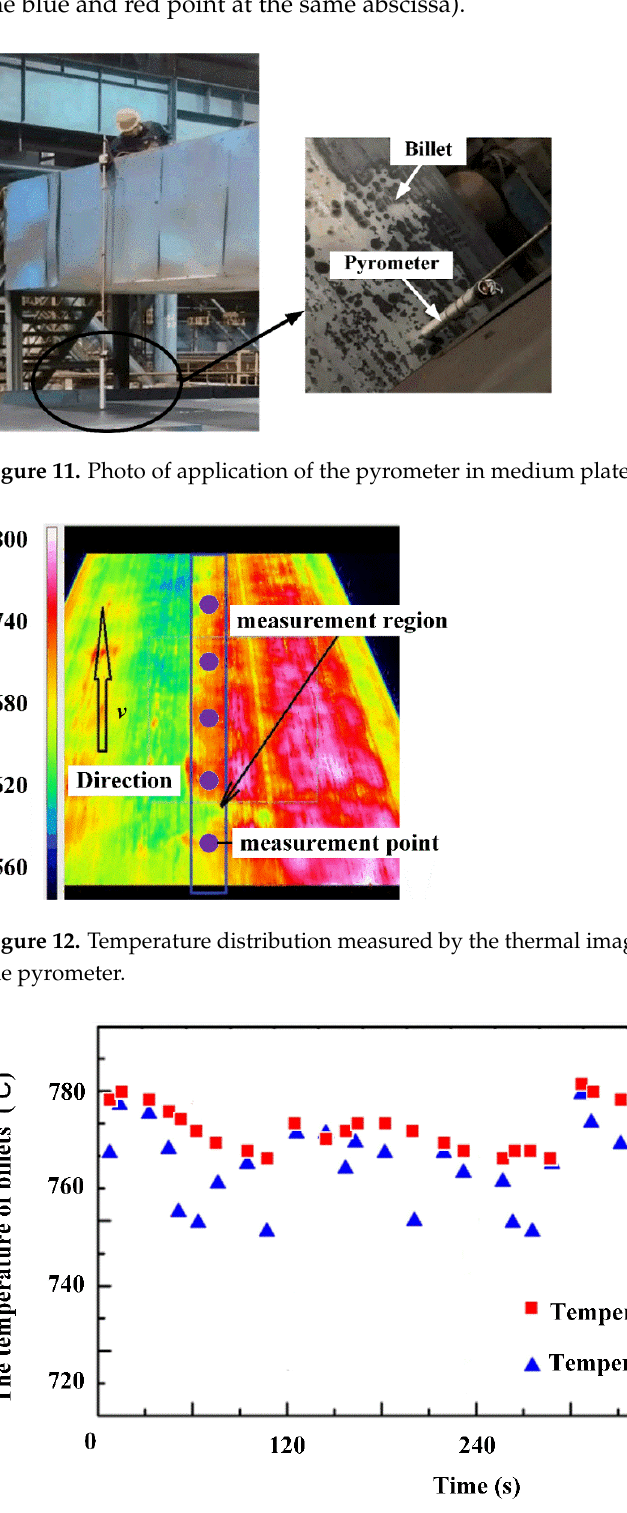
Figure 13. Comparison between the temperatures measured by the pyrometer and thermal imager. The oxide scale is unevenly distributed due to the dephosphorization of the billet surface. The emissivity of the surface is between 0.3 and 1. However, the thermal